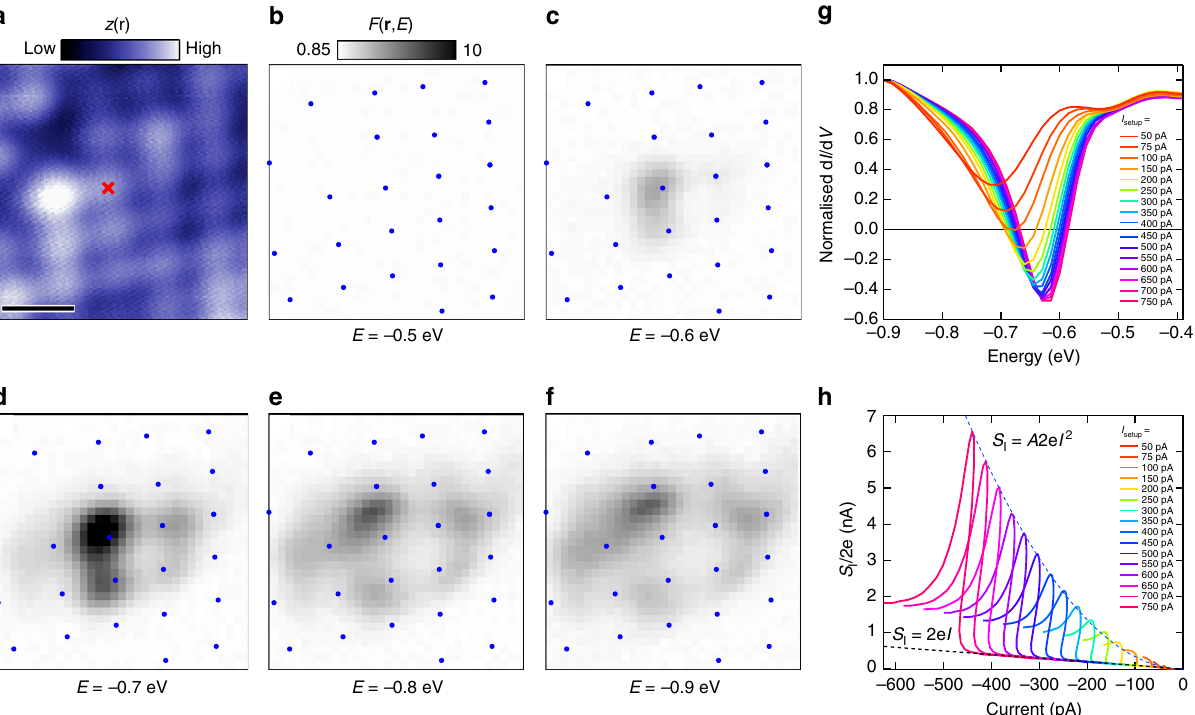
Fig. 3 Negative differential conductance and dispersion. a Constant current image of an area with a noisy defect ( E = − 100 meV, I = 100 pA). The scale bar indicates 0.5 nm. b – f Spatially resolved current-noise for fi ve different energies: the noise initially appears (in ( c )) on top of four neighbouring Bi atoms, then radially moves outwards for increasing energies (each energy is recorded at I setup = 400 pA). Blue dots mark the location of the Bi atoms in ( a ). g Differential conductance taken on the Bi atom marked in ( a ) for increasing setup currents ( E setup = − 1 eV), becoming negative for I setup > 100 pA. h Current-noise recorded simultaneously with ( g ). Poissonian ( S I = 2e I ) and quadratic dependence of the noise on current ( S I = A 2e I 2 , A = 3.4 × 10 10 ) are indicated with dotted